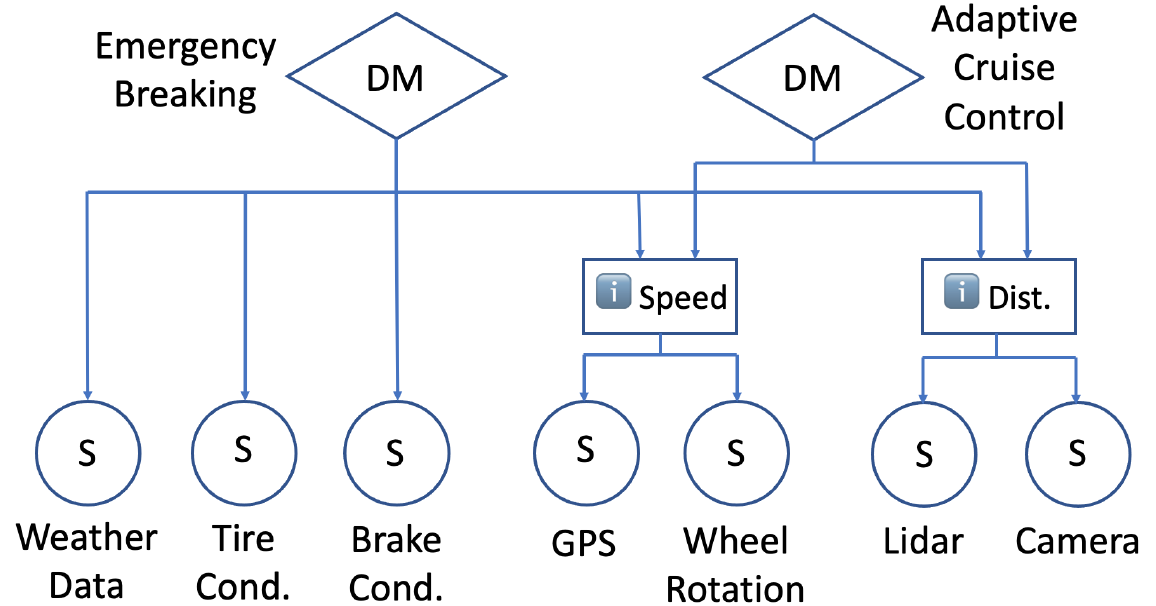
Figure 3. Sample diagram of an active safety system in a